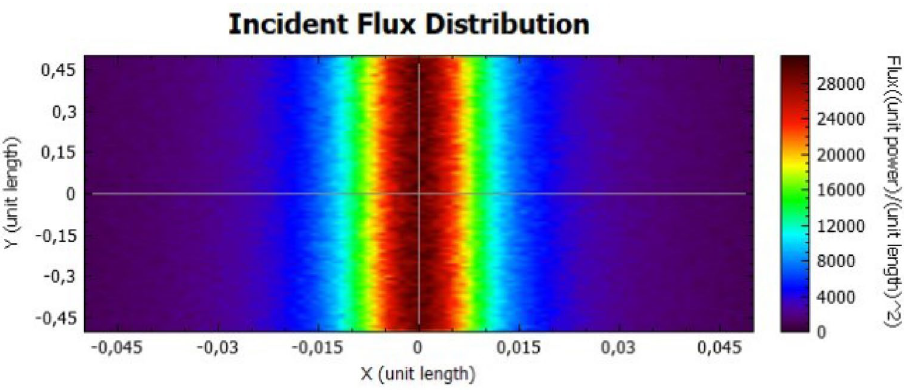
Figure 18. Incident Flux Distribution for an optical error of 0.010 (Parabolic Concentrator; 92% of reflectivity).